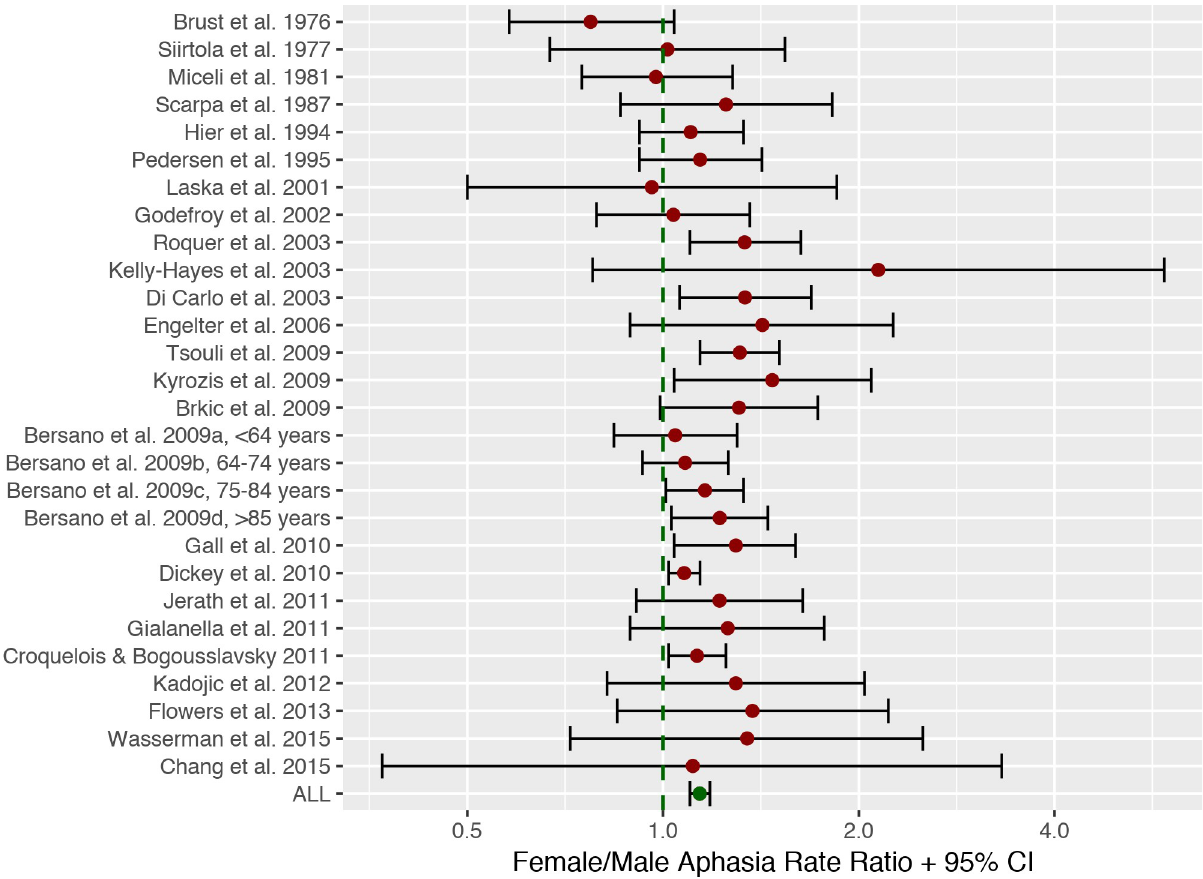
Fig 2. Meta-analysis forest plot. Forest plot of aphasia rate ratios between males and females for the 25 studies included in the meta-analysis (total n = 48,362), showing that across studies a small but significant effect of sex exists, indicating that women are more likely to get aphasia from stroke. This effect, however, does not take age or stroke severity into